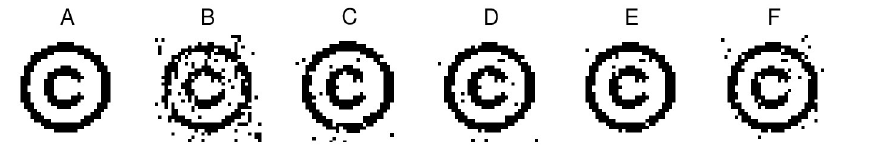
Fig 5. DWT-DCT scheme used to extract the watermark